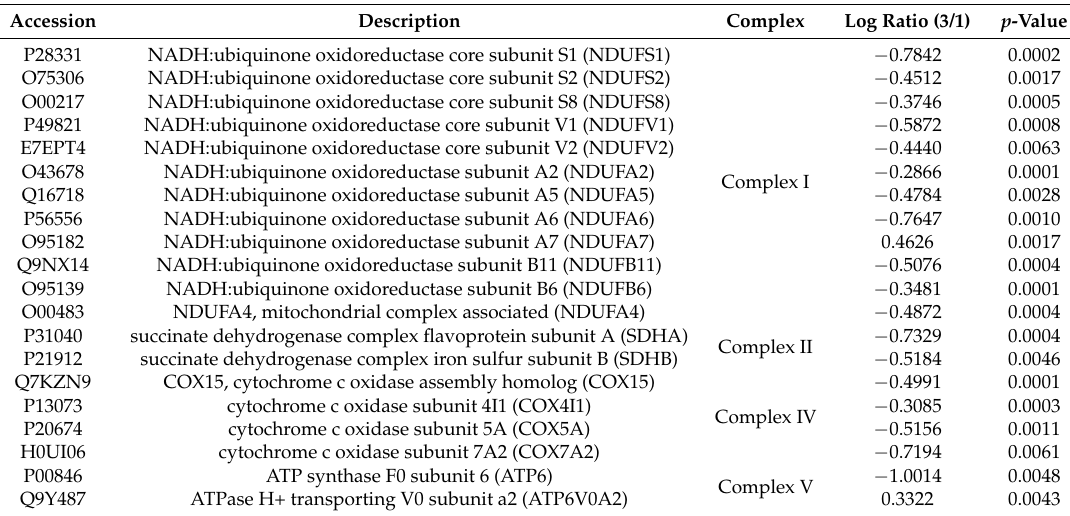
Table 2. The differentially expressed proteins involved in the oxidative phosphorylation pathway and respiratory chain